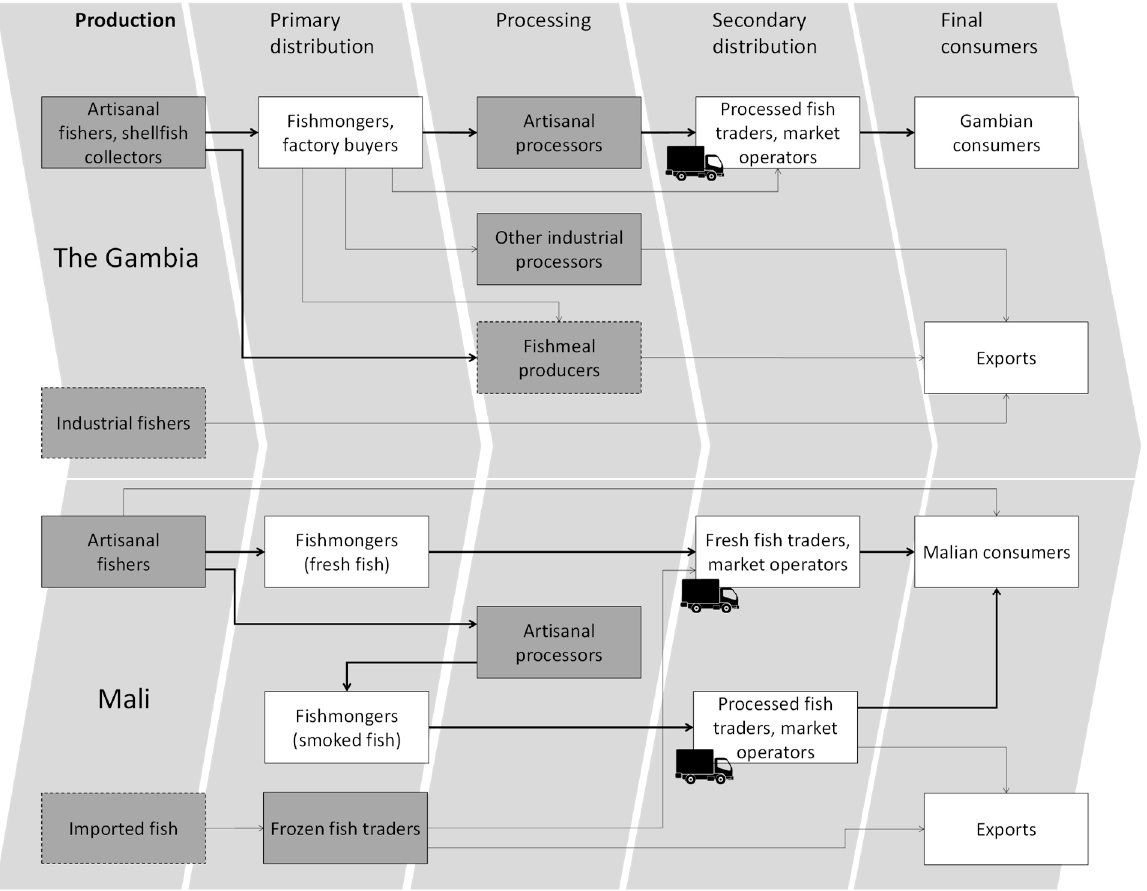
Figure 1. Simplified scheme of the Gambian and Malian fishery value chains (blocks in grey and transport icons represent systems modelled in the LCA; thicker lines represent more important flows; dotted boxes represent modelling based on secondary data and proxies.